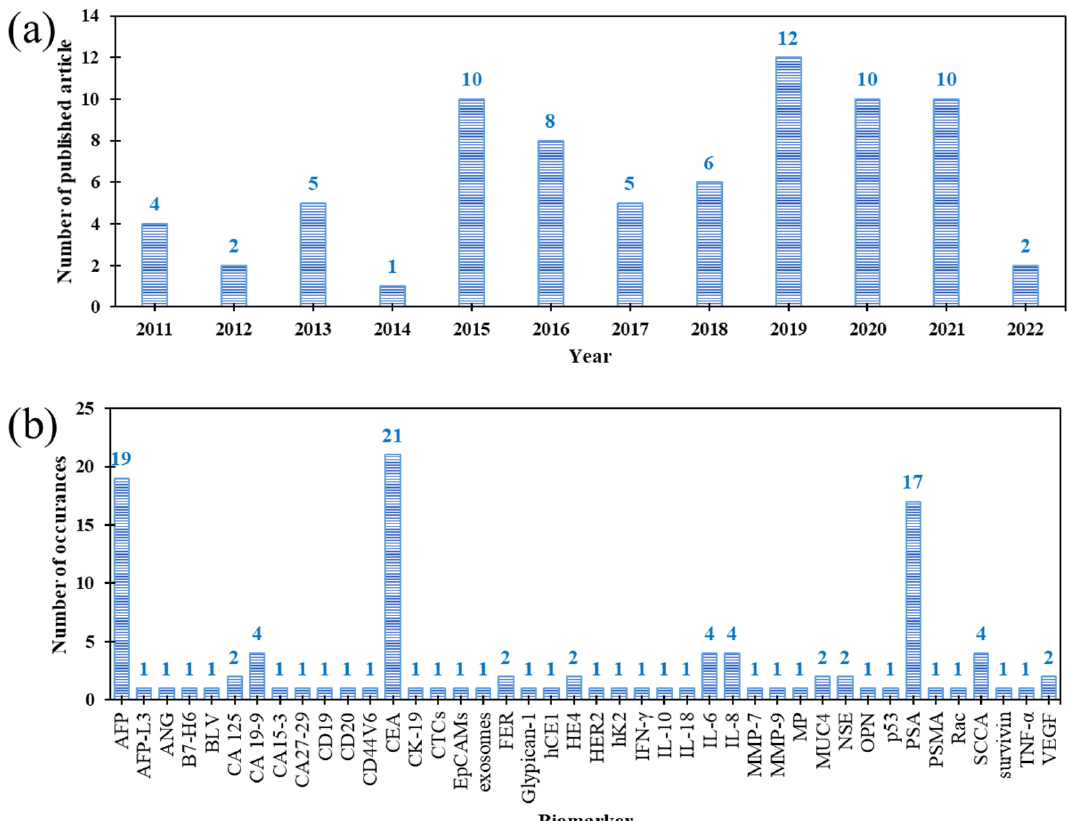
Figure 2. ( a ) Number of published articles during the period of 2011 to 2022 (February) based on Scopus, ScienceDirect, PubMed, Web of Science, and Google Scholar. ( b ) Number of biomarker oc- currences in the published articles, where: AFP— α -fetoprotein; AFP-L3—lectin-reactive α